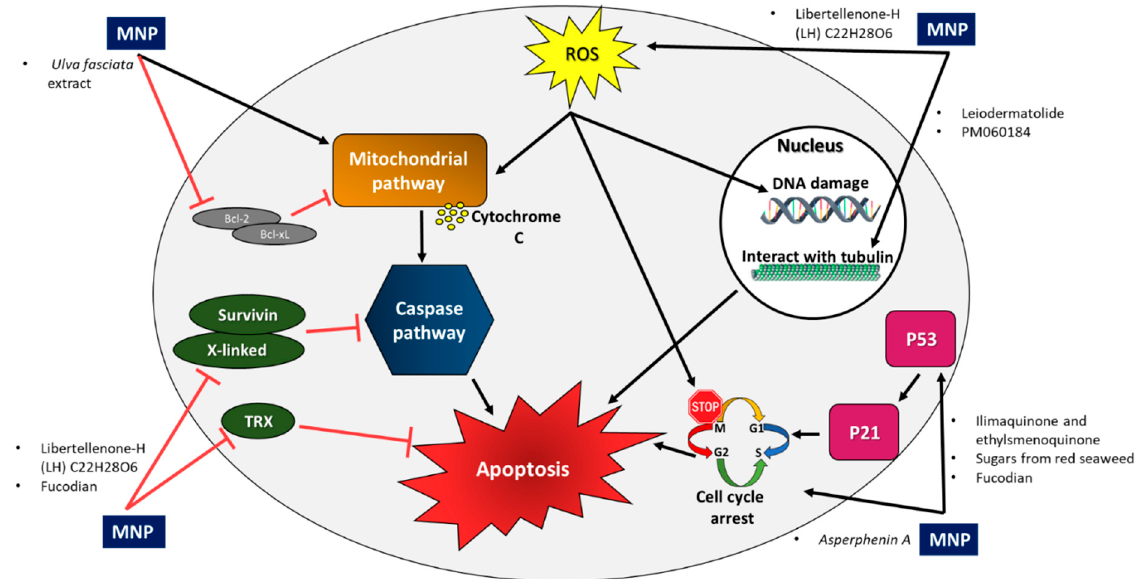
Figure 2. Main mechanisms of action of marine natural products (MNPs) on colon and pancreatic cancer. Caspase activation pathway: Caspases are a family of protease enzymes that play essential roles in apoptosis, and they can be activated by the mitochondrial pathway . The permeability of the mitochondrial outer membrane is the key mechanism for caspase activation. Release of mito- chondrial components, such as cytochrome c, leads to caspase-9 activation, which leads to activation of downstream caspases (-3, -6, and -7) and induction of apoptosis. Pro-apoptotic and anti-apoptotic members of the Bcl-2 protein family control the permeability of the outer mitochondrial membrane